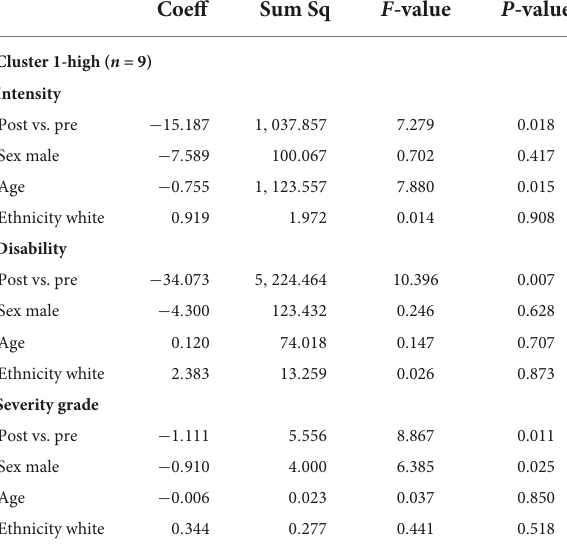
TABLE 5 Multivariable ANOVA, adjusted for demographics (sex male vs. female, age, ethnicity white vs. non-white) for the total sample ( n = 32). Coeff Sum Sq F -value P -value